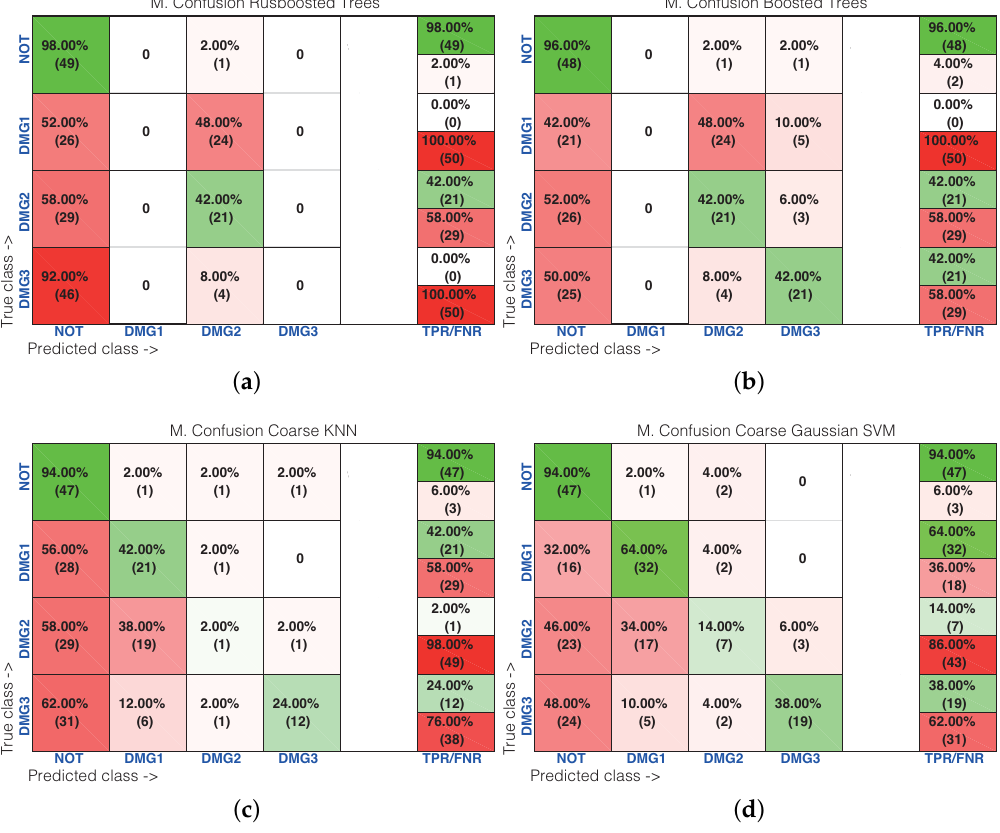
Figure 17. Confusion matrix using: ( a ) rusboosted trees; ( b ) boosted trees; ( c ) coarse k -NN; and ( d ) coarse Gaussian SVM.